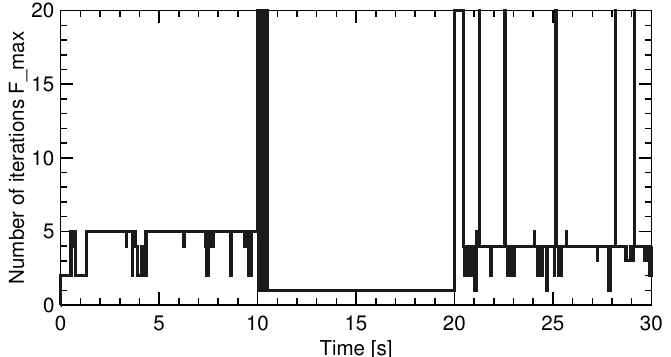
Figure 36. Generalized Newton–Raphson (GNR)—number of algorithm